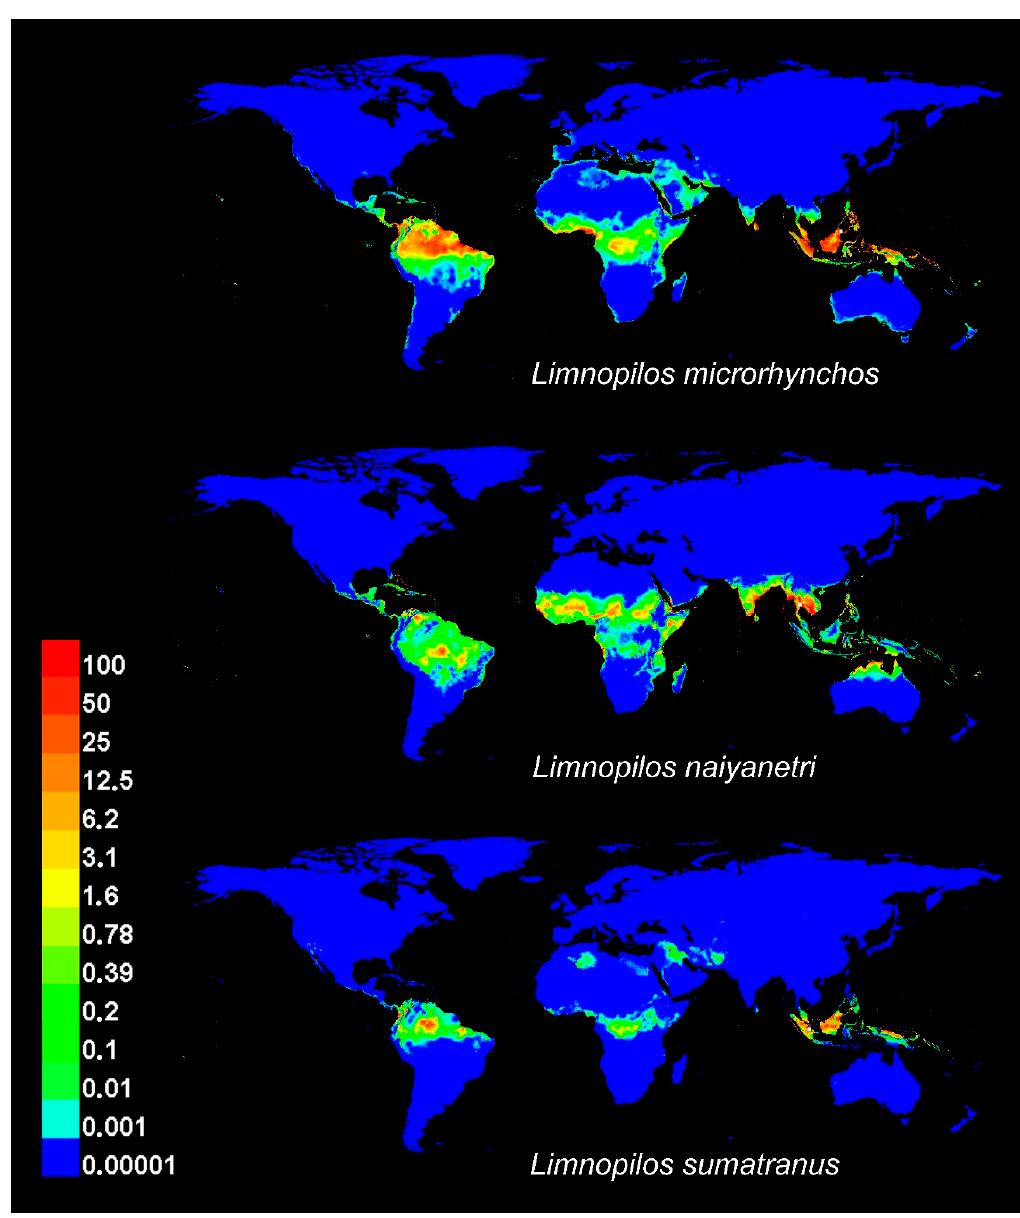
Figure 1. Worldwide environmental suitability for Limnopilos crabs ( L . microrhynchus , L . naiyanetri , and L . sumatranus ) based on environmental predictors in the MaxEnt model. Suitability is shown in different colors representing the percentage value, with red indicating the highest probability of establishment (100%).